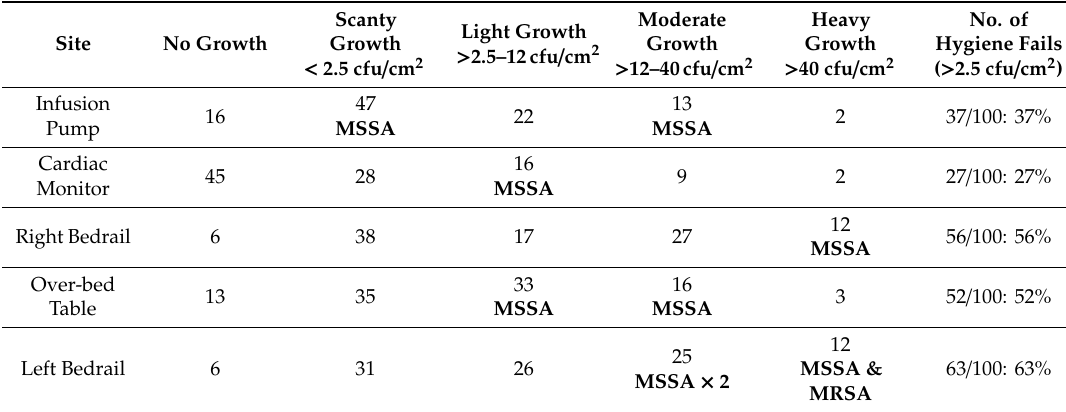
Table 1. Microbial soil categories for five hand-touch sites on ICU.